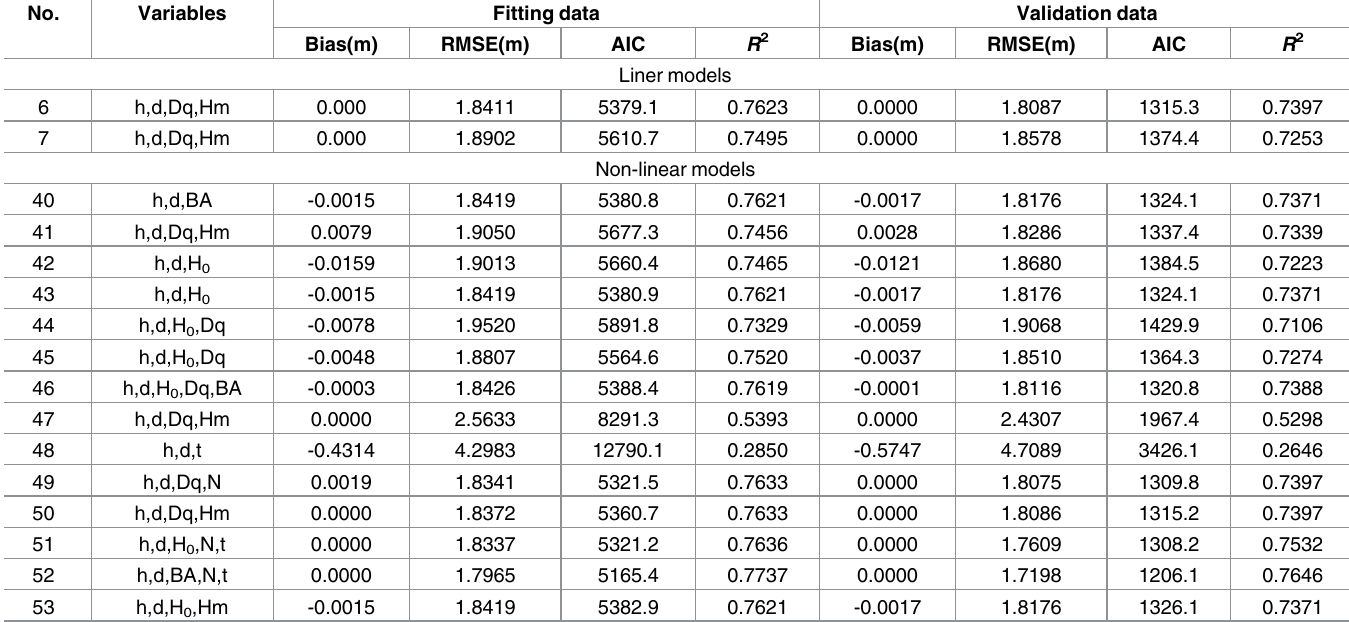
Table 4. Calibration data and validation data adaptive statistics for models in Group 2. doi: 10.6084/m9.figshare.4956284.t004.